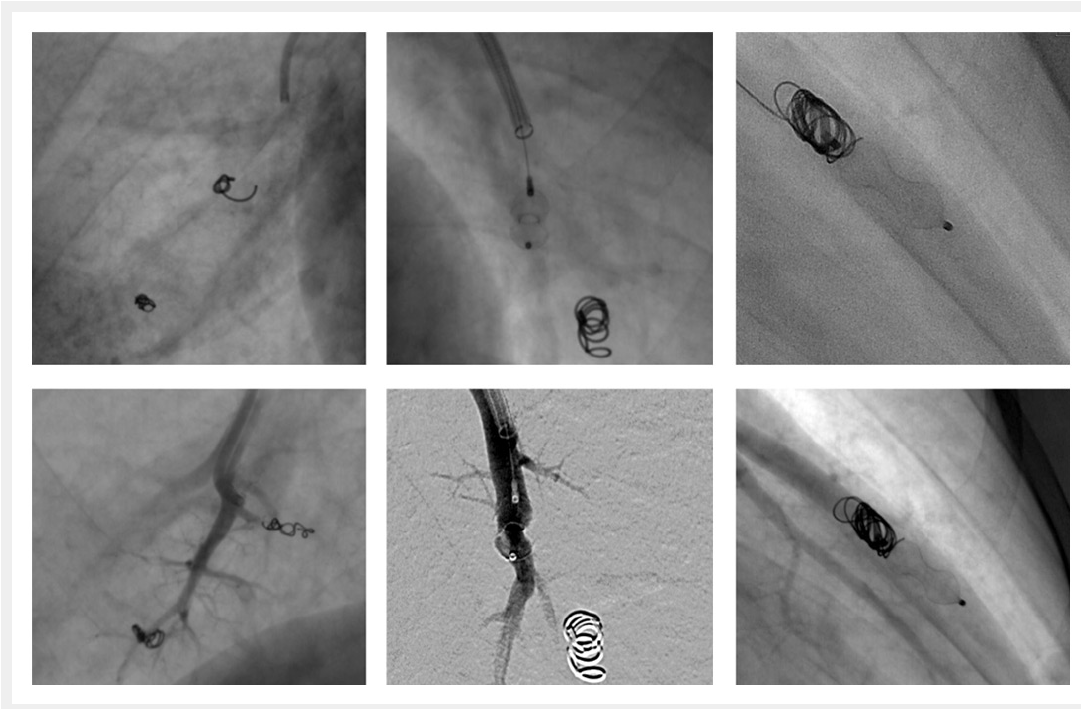
Figure 3 Examples of pulmonary arteriovenous malformation endovascular vaso-occlusions with vascular coils, plugs and combined treatment. Beneath each case is an angiographic control showing no vascular opacification beyond the occlusive